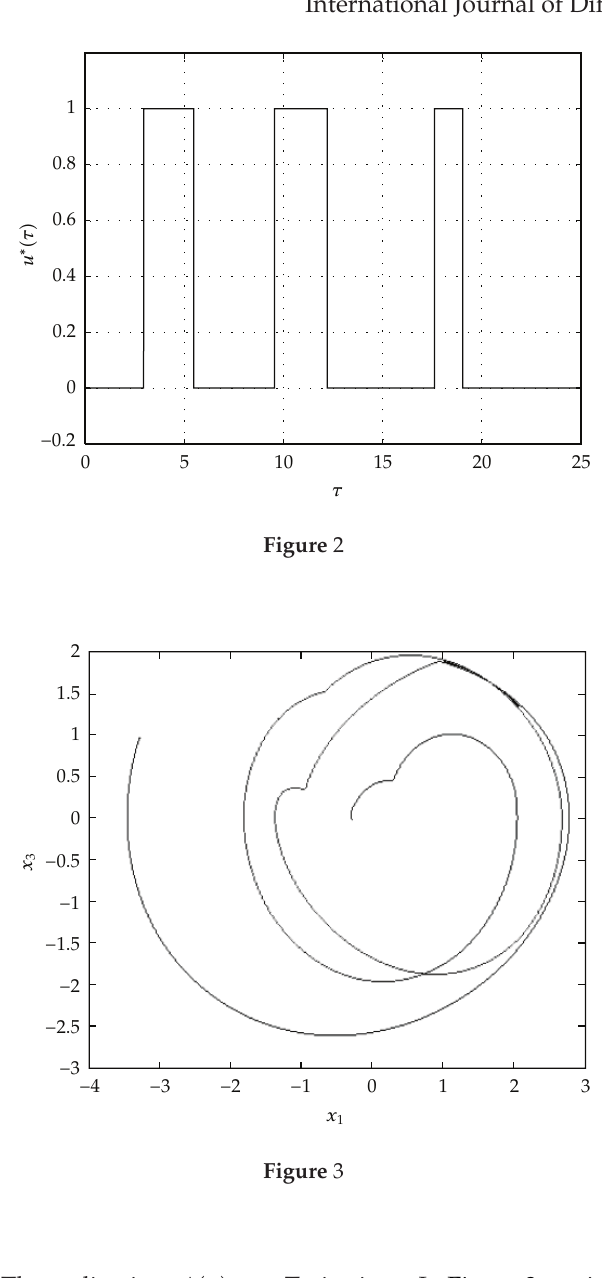
In Figure 2, The realization u ∗ (cid:3) τ (cid:4) , τ ∈ T h , is given. In Figure 3, projections of transients of system (cid:3) 8.1 (cid:4) closed by optimal open-loop on planes x 1 x 3 are presented. In Figure